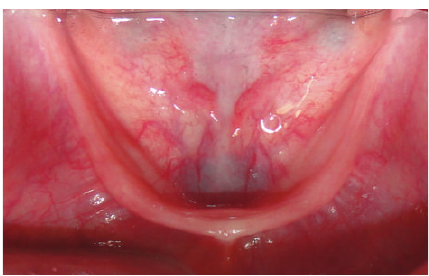
Figure 3: Occlusal view of the mandible.